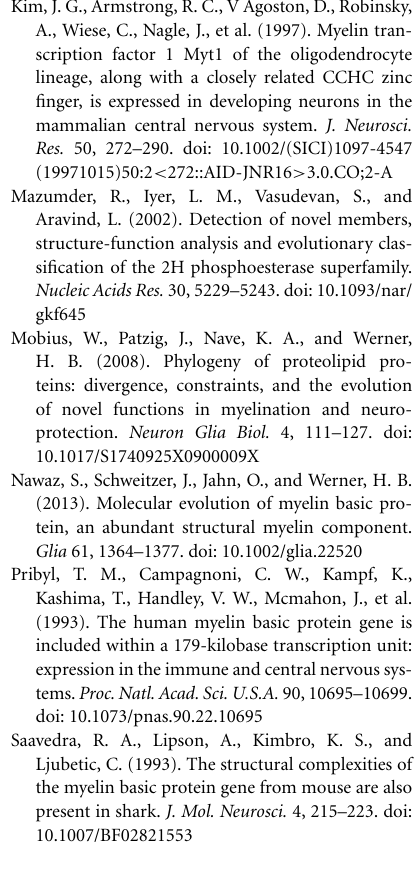
the Lasergene package was used with standard slow-accurate parameters of ClustalW and protein weight matrix Gonnet25O. Note that the sea lamprey fragment is highly homolog to GOLLI over a stretch of more than 20 amino acids as indicated by the red coloring in the consensus sequence [marked by the red arrowheads in (A) ]. In contrast, no considerable similarity with MBP was identified (B)